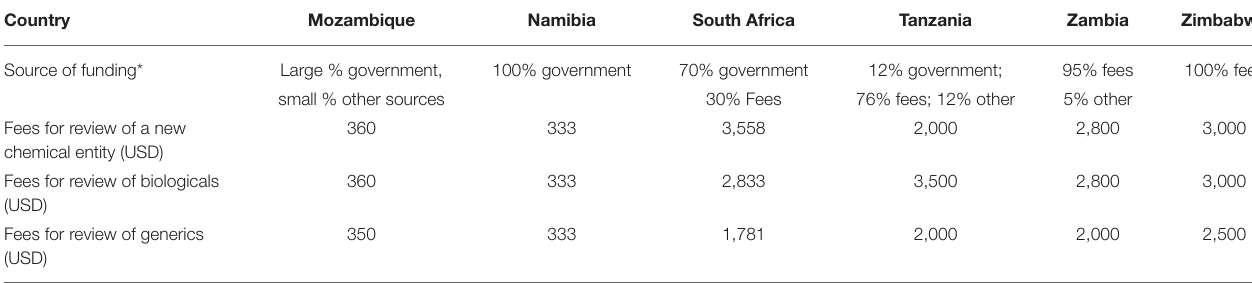
TABLE 2 | Comparison of fees charged and source of funding in 2019.